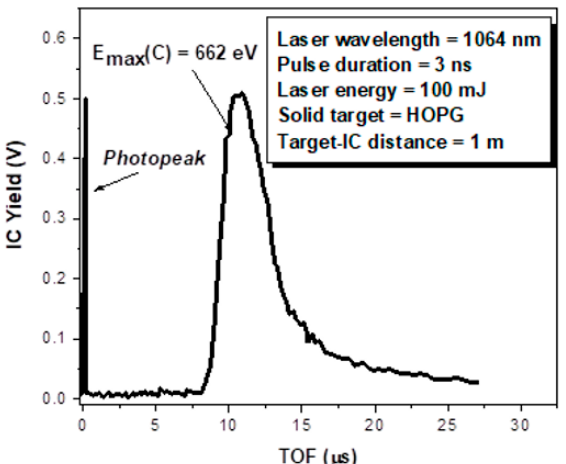
Figure 3. Spectra in TOF obtained from a faraday cup for a target of HOPG irradiated by laser.